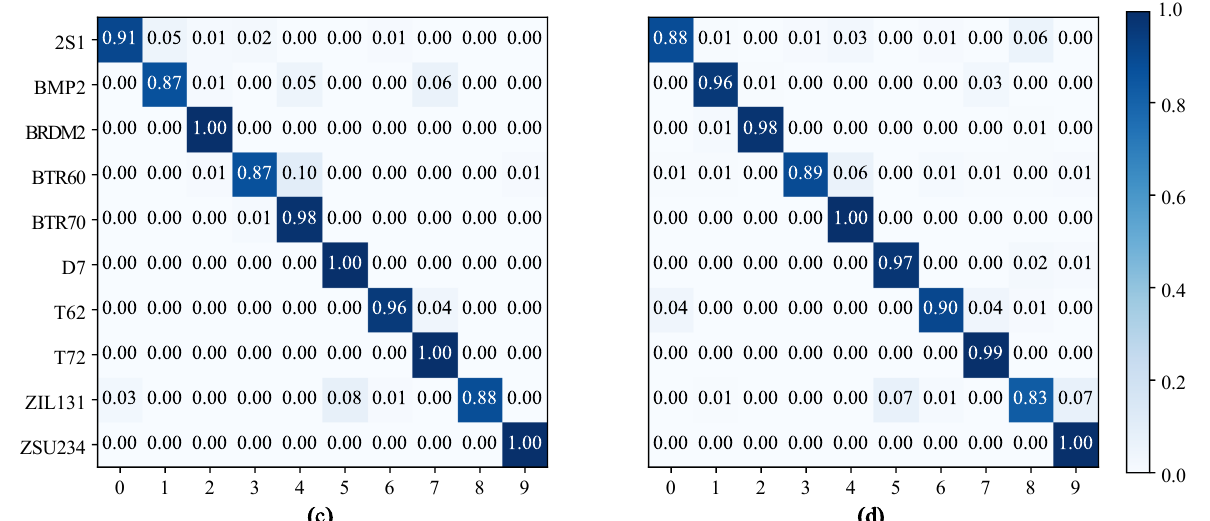
Figure 6. Confusion matrices of the proposed method and other mixed semi-supervised learning methods under 10 labeled samples per category ( a ) MBM; ( b ) cutmix; ( c ) mixup; ( d ) unmixed. The average performance per method is 97.21%, 96.75%, 94.92%, and 93.75%.